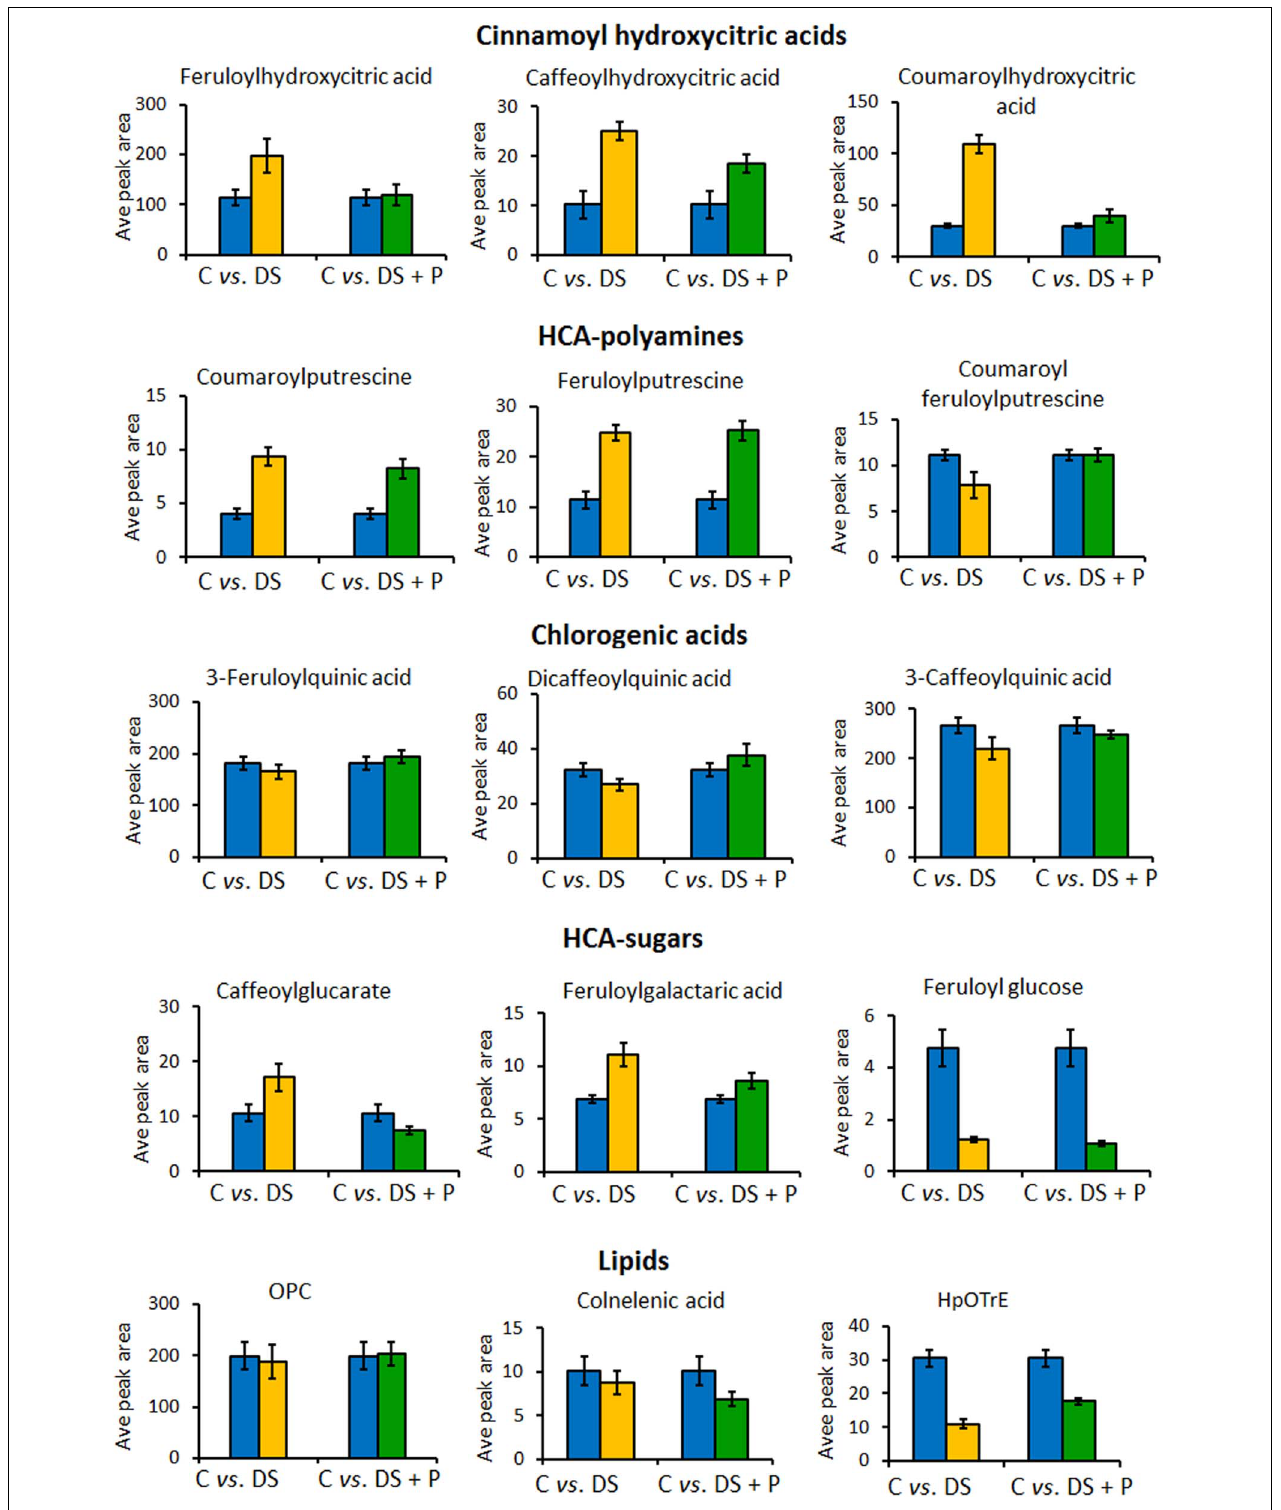
FIGURE 6 | Relative quantitative profiles of some of the phenolic compounds in naïve unstressed plants (C = control), naïve stressed plants (DS = drought stress), and PGPR-primed stressed plants (DS+P = drought stress + PGPR). The bar graphs were generated using averaged integrated peak area ( n = 9) and the error bars represent the standard deviation. For statistical significance evaluation, the p -values are reported in Supplementary Table 1 . OPC, oxo-(pentenyl)cyclopentane-octanoic acid; HpOTrE, hydroperoxy-octadecatrienoic acid.